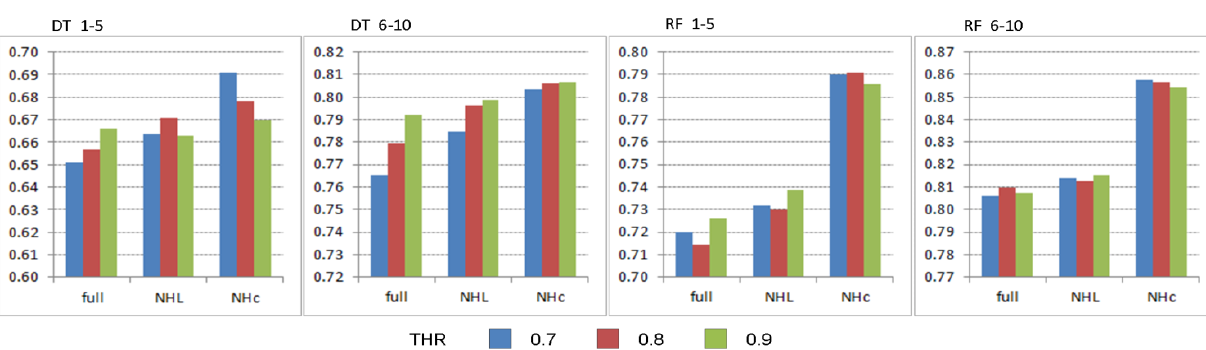
Figure 7. Illustrating the effect of different confidence threshold (THR) values as average classification accuracies over the three search neighborhoods using DT and RF as base learners within